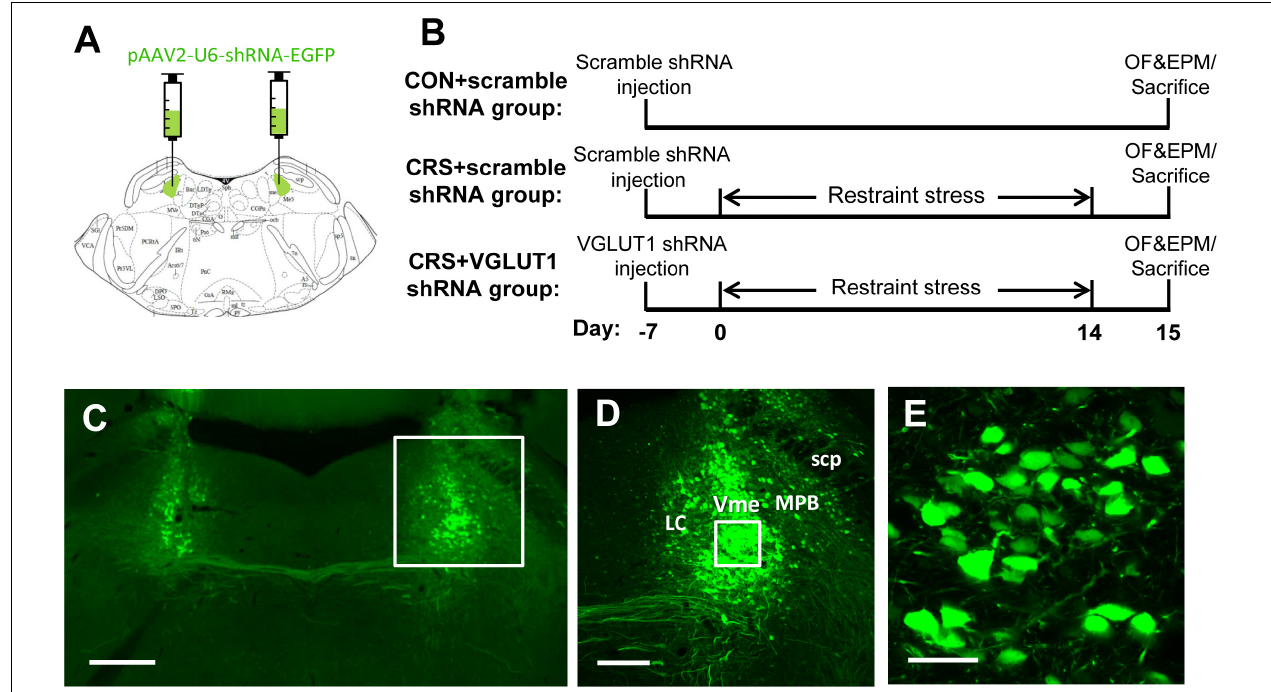
FIGURE 4 | Representative schematic diagrams of the VGLUT1 shRNA vector injected into the bilateral Vme (A) and procedures for vector injection, restraint stress, behavioral tests, and sampling (B) . (C–E) Integration of virus vectors into Vme neurons. (C) Bilateral injection of VGLUT1 shRNA vectors into the Vme. The framed area in panel (C) and panel (D) is magnified in panel (D) and panel (E) , respectively. Successful transfection was morphologically verified by green fluorescent proteins knocked into the neurons. Scale bars: 500 µ m in panel (C) ; 200 µ m in panel (D) ; 50 µ m in panel (E)